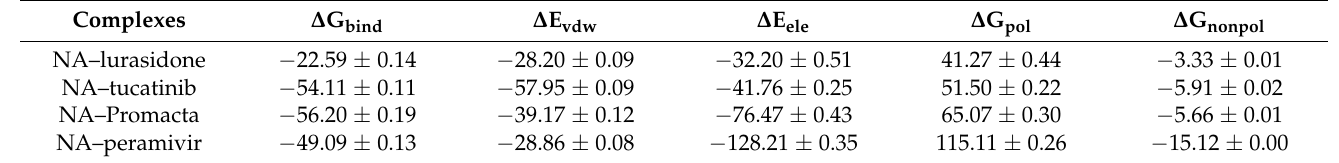
Table 2. Binding free energy contributions for NA–ligand